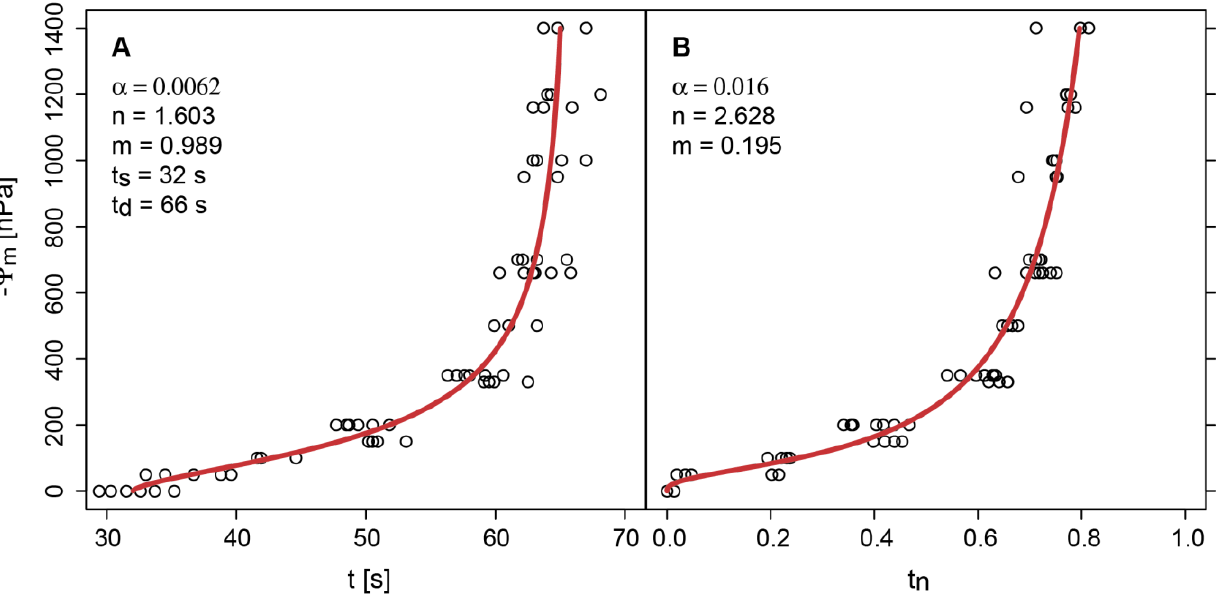
Figure 4. ( A ) Calibration of the PlantCare sensor signals in a pressure plate apparatus (circles) expressed as absolute cooling time t fitted with Equation (3) and ( B ) as normalized cooling time t fitted with Equation (2). The threshold temperature was 18% n (Figure